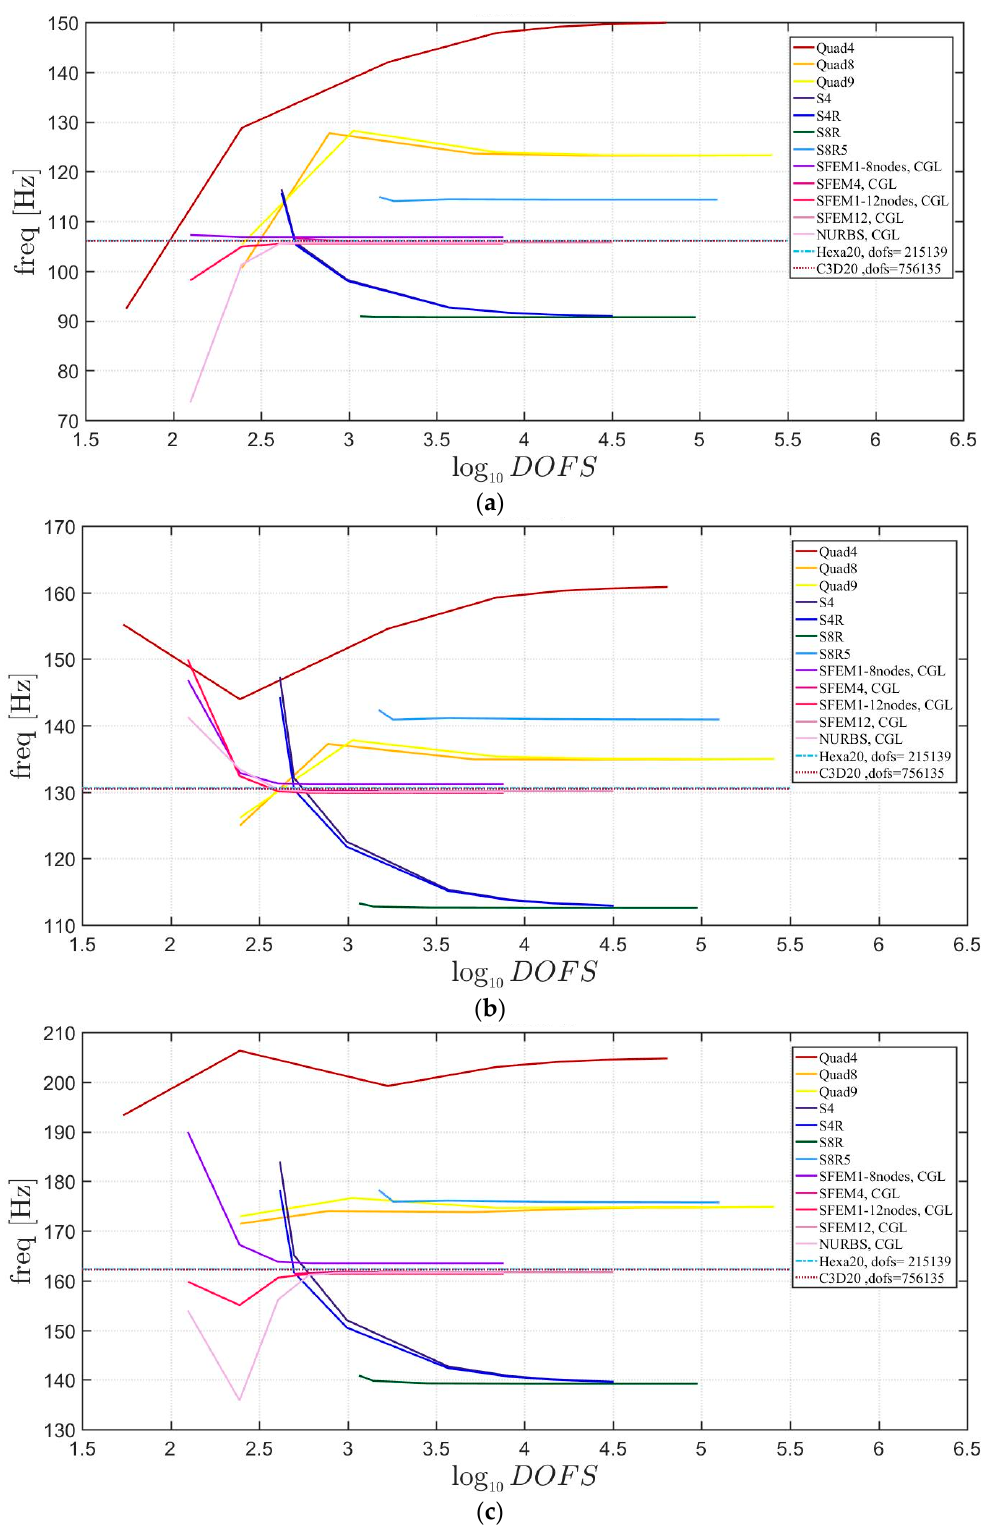
Figure 31. First three natural frequencies of an elliptic plate with a / b = 2.5 a not-symmetric lamination scheme and a / h = 10: ( a ) First frequency; ( b ) Second frequency; ( c ) Third frequency.